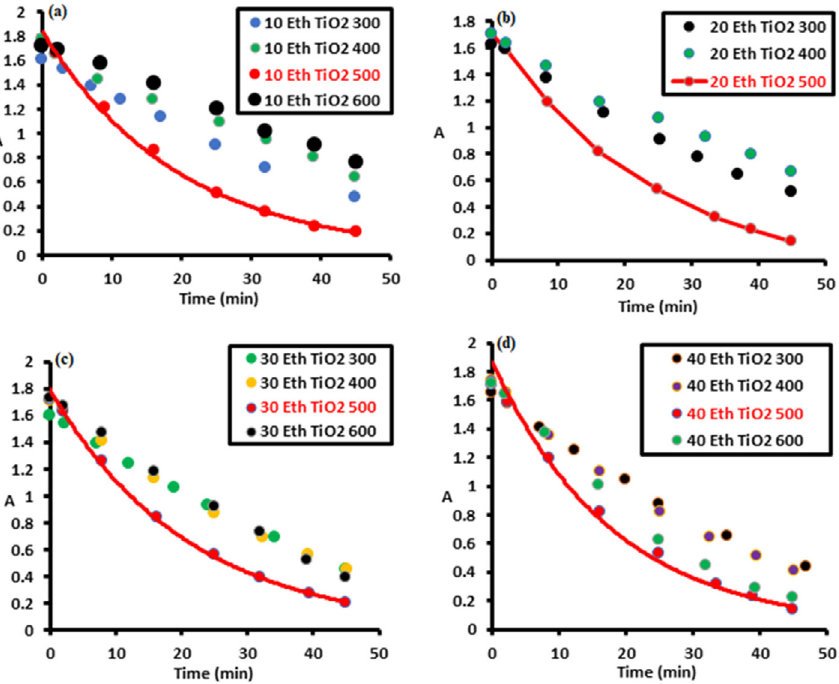
Fig. 10. Photocatalytic degradation of E 131 VF dye in the presence of TiO prepared with different volumes of ethanol and calcined at 2 different temperatures (a) 10 mL; (b) 20 mL; (c) 30 mL; (d) 40 mL ethanol